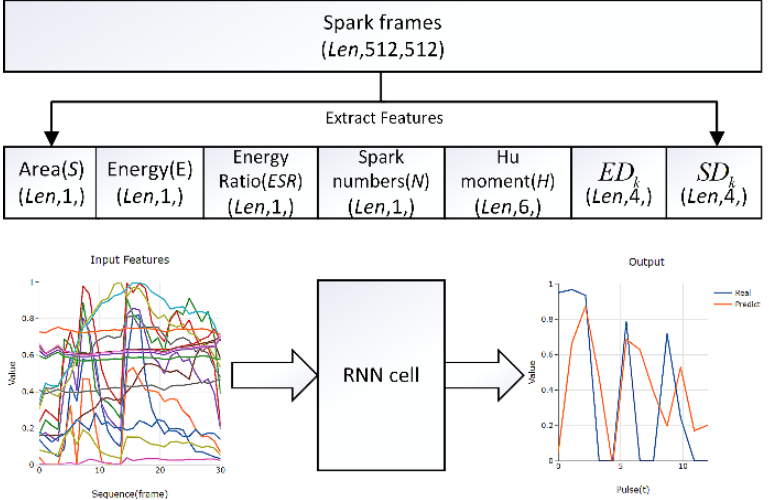
Figure 4. “Sequence to sequence” model.